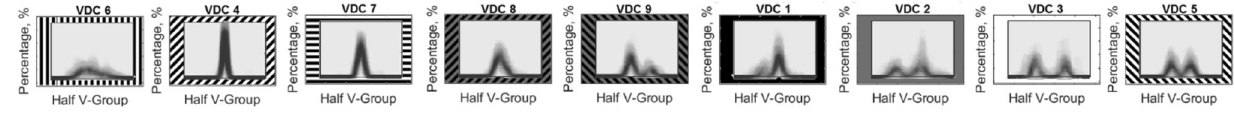
Fig. 7 VDCs sorted by model coefficient (smallest at left, greatest at right). The greater the model coefficient, the greater the underprediction by the original model. VDC numbering is consistent with that used Fig. 3